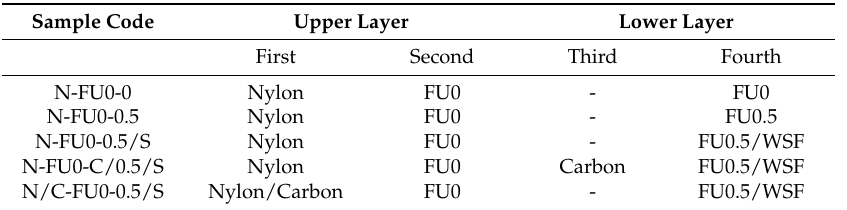
Table 1. Formulation details of MFRCs.